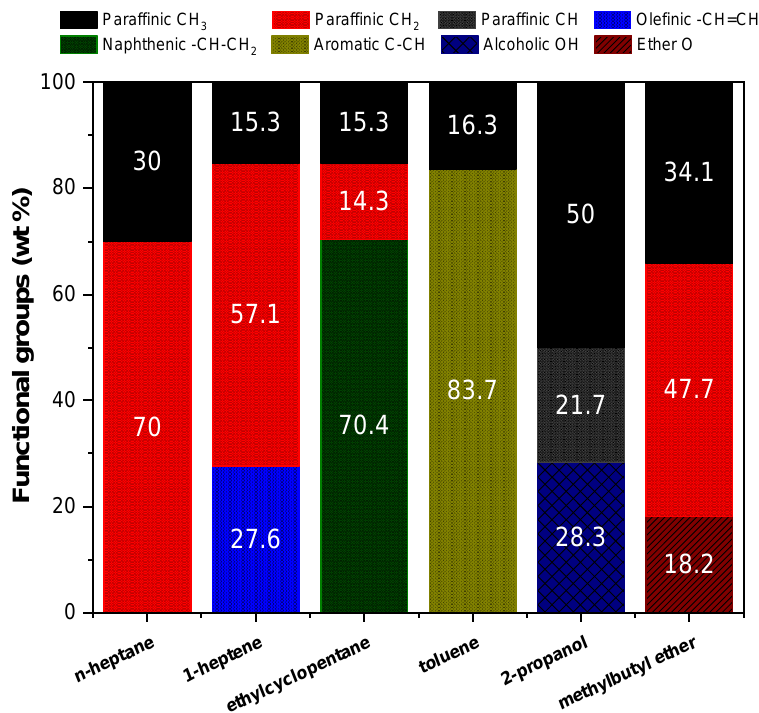
Figure 1. Functional group distribution of some compounds.